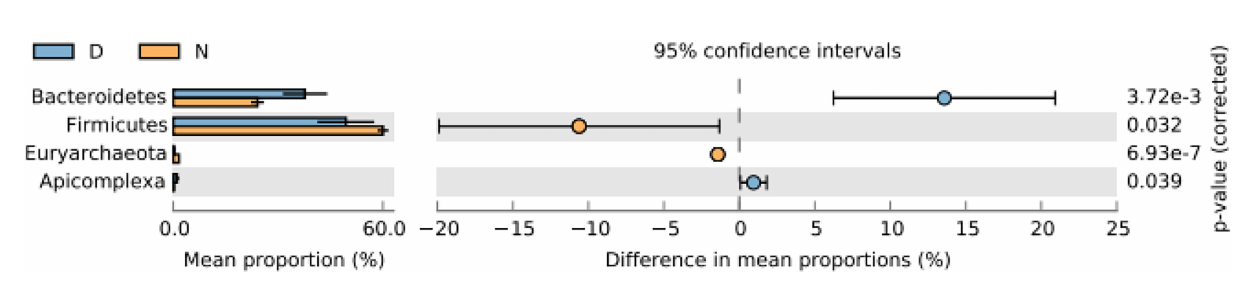
FIGURE 1 | Comparing intestinal microbiota difference between different yaks at phylum level. D, diarrheal group samples; N, normal group